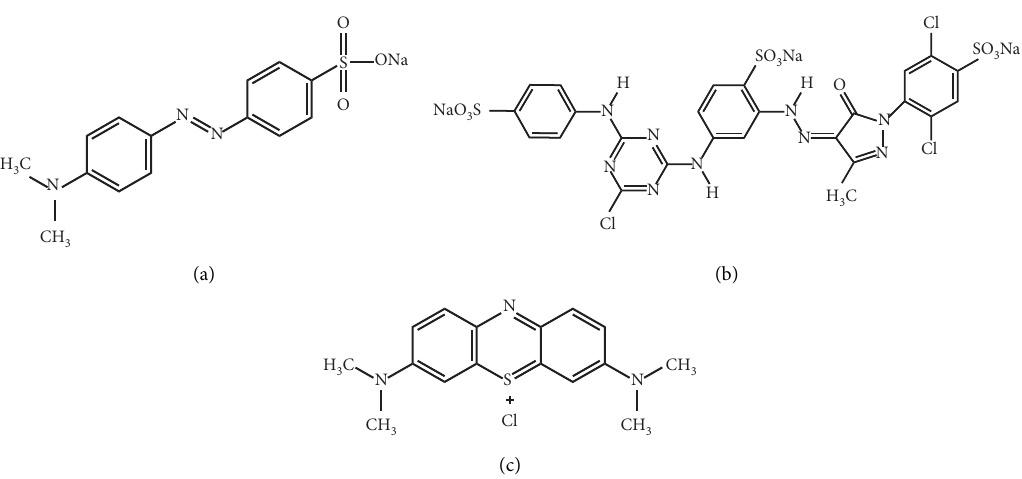
Figure 1: Structures of selected dyes: (a) methyl orange, (b) reactive yellow-II, and (c) methylene